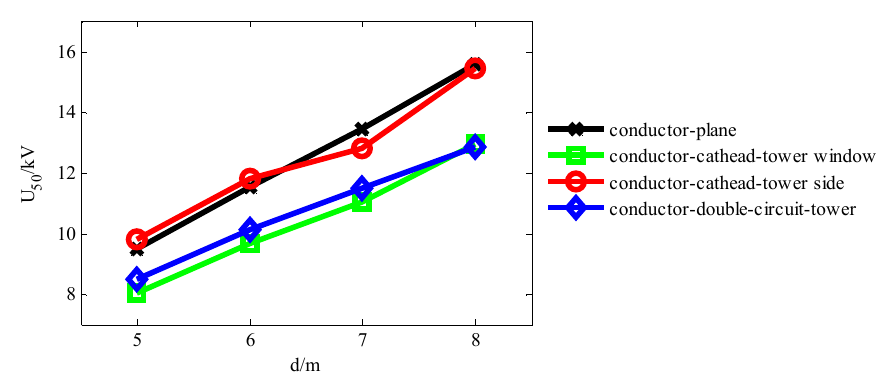
Figure 8. Gap characteristic factors of different gaps.